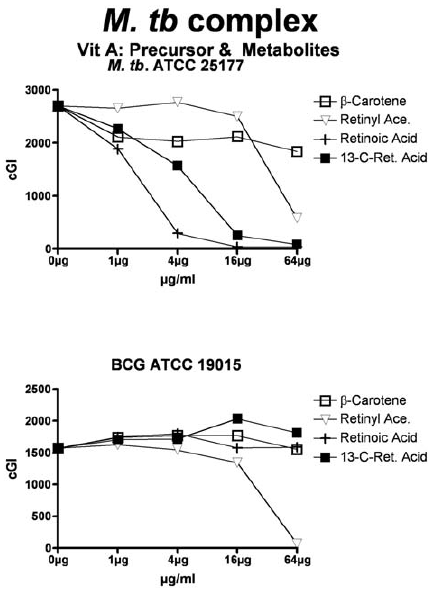
Figure 9. The effects of vitamin A precursors and metabolites on M.tb.complex. ß-carotene, the precursor to vitamin A, exhibits no inhibition at the doses studied. Both Retinoic acid and 13-cis Retinoic acid result in dose dependent inhibition on our avirulent strain of M. tb . There is no comparable inhibition against Bacillus Calmette-Guerin (BCG).